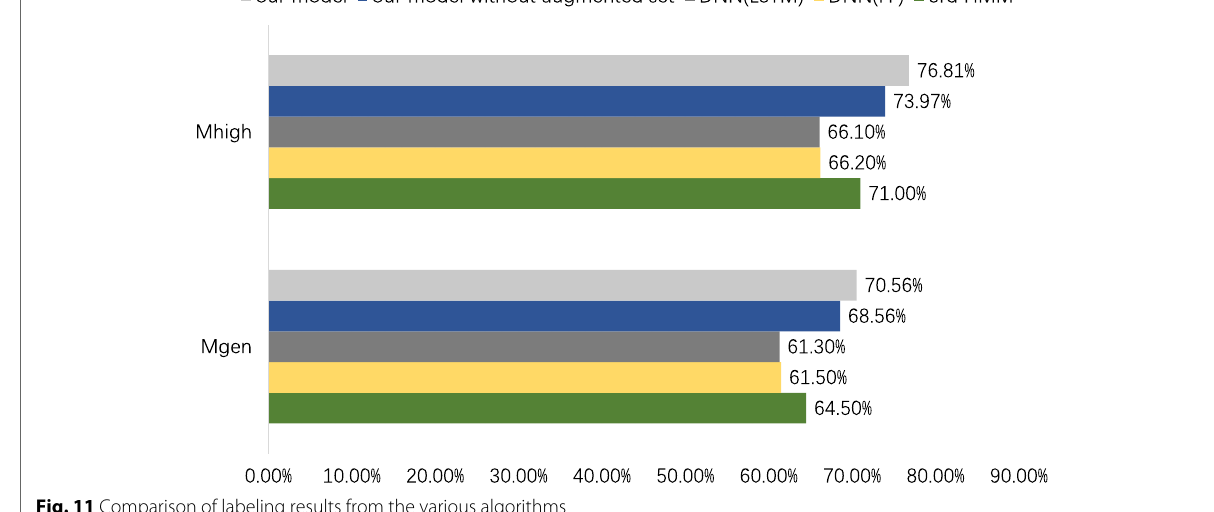
Fig. 11. Overall, the proposed model outperformed the other methods in terms of M gen and M high . Compared with the current best-performing 3rd HMM, our method improves M gen by 6.06% and M high by 5.81%. Without the augmented set, the match rates were increased by 4.06% and 2.97%,